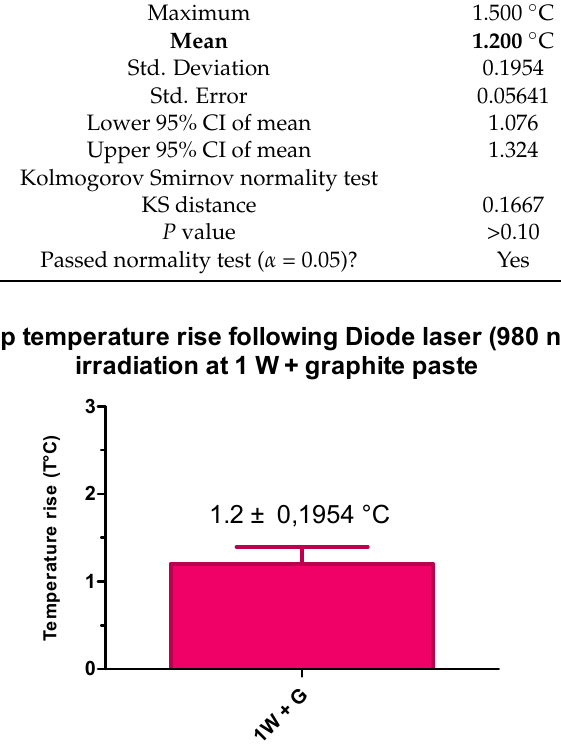
Figure 2. Results of temperature rise following diode laser (980 nm) irradiation at 1 W+ graphite paste. G = Graphite paste.